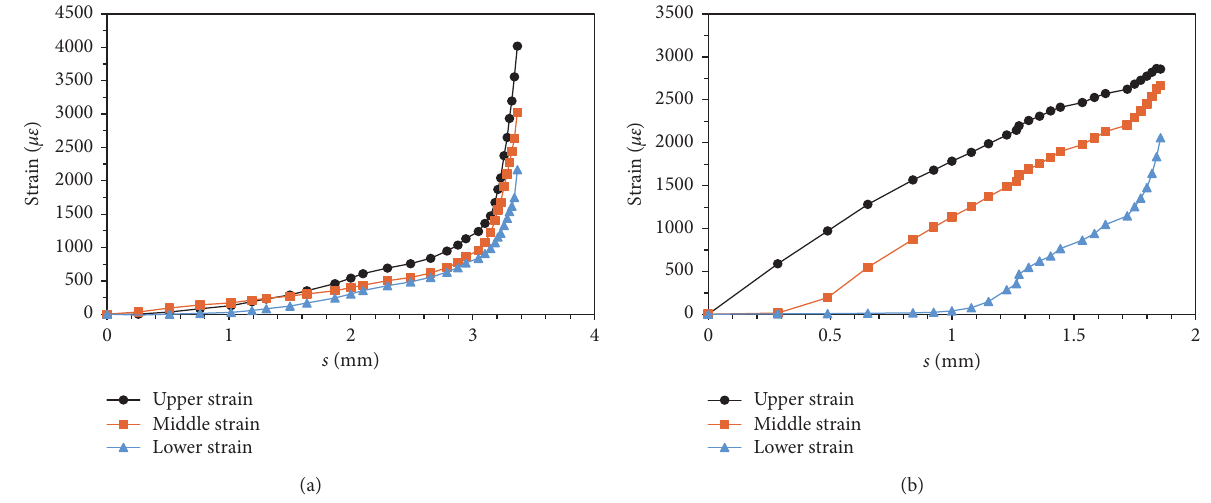
Figure 13: Strain-slip curves of specimens with internal threads. (a) 4-2. (b) P-2.